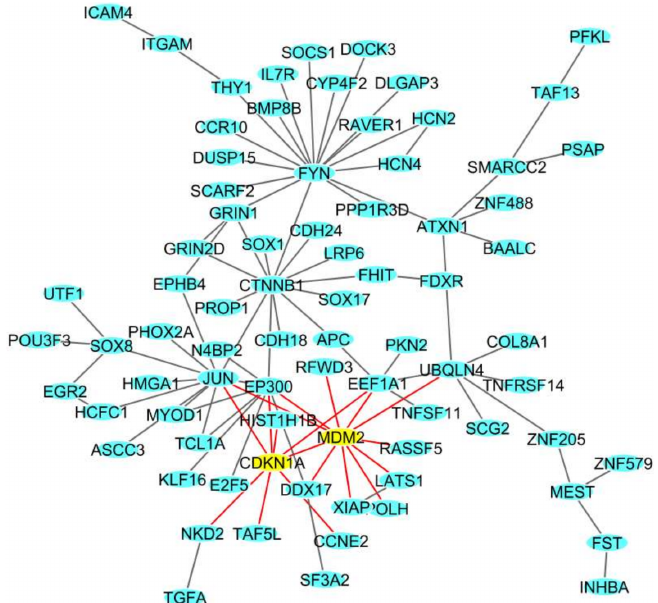
Figure 2. The deregulated densest protein-protein network (blue nodes: proteins, yellow nodes: proteins involved in crucial pathways, red edges: interactions involved yellow nodes) in the MCF10A breast cell line: nodes represent genes and edges represent protein